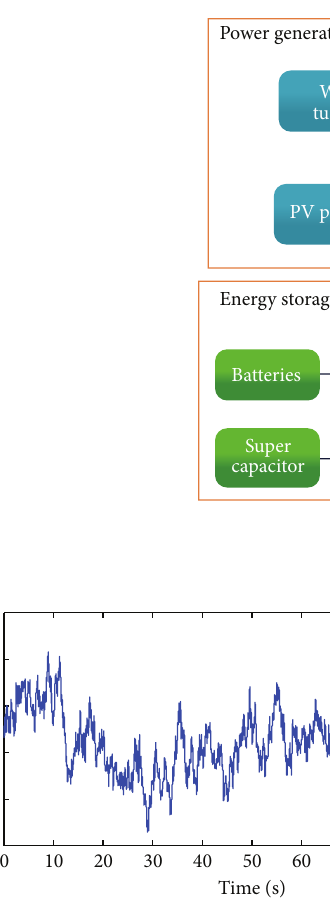
Figure 4: The maximum output power of PV